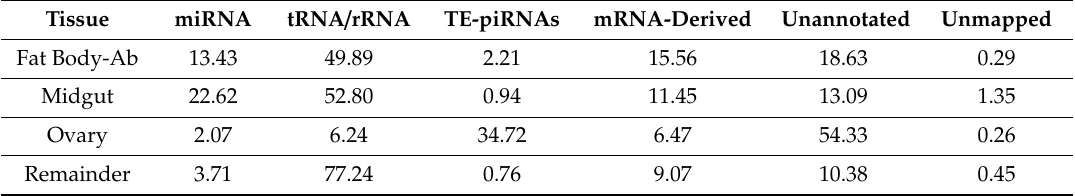
Table 1. Average percentage of mapped reads to small ncRNA groups across mosquito tissues. Tissue